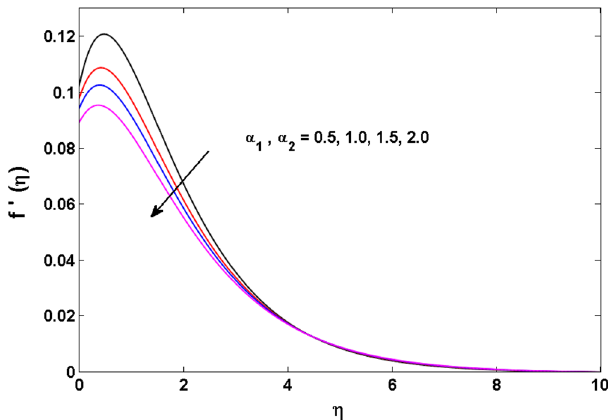
Figure 6. Variations of α 1 , α 2 to f ′ (η) .